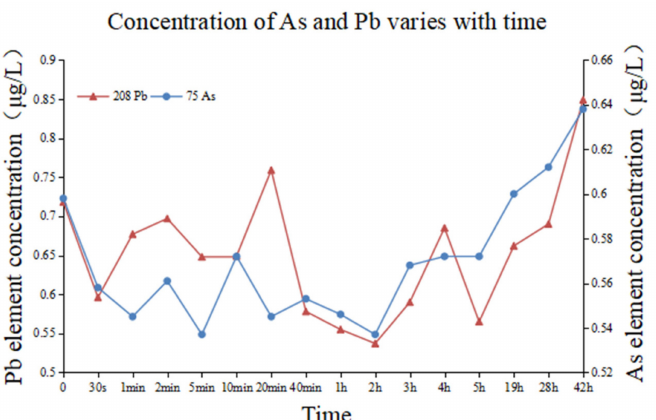
Figure 12. In conventional treatment water the effects of suspended particulate matter at different time adsorption and release of As and